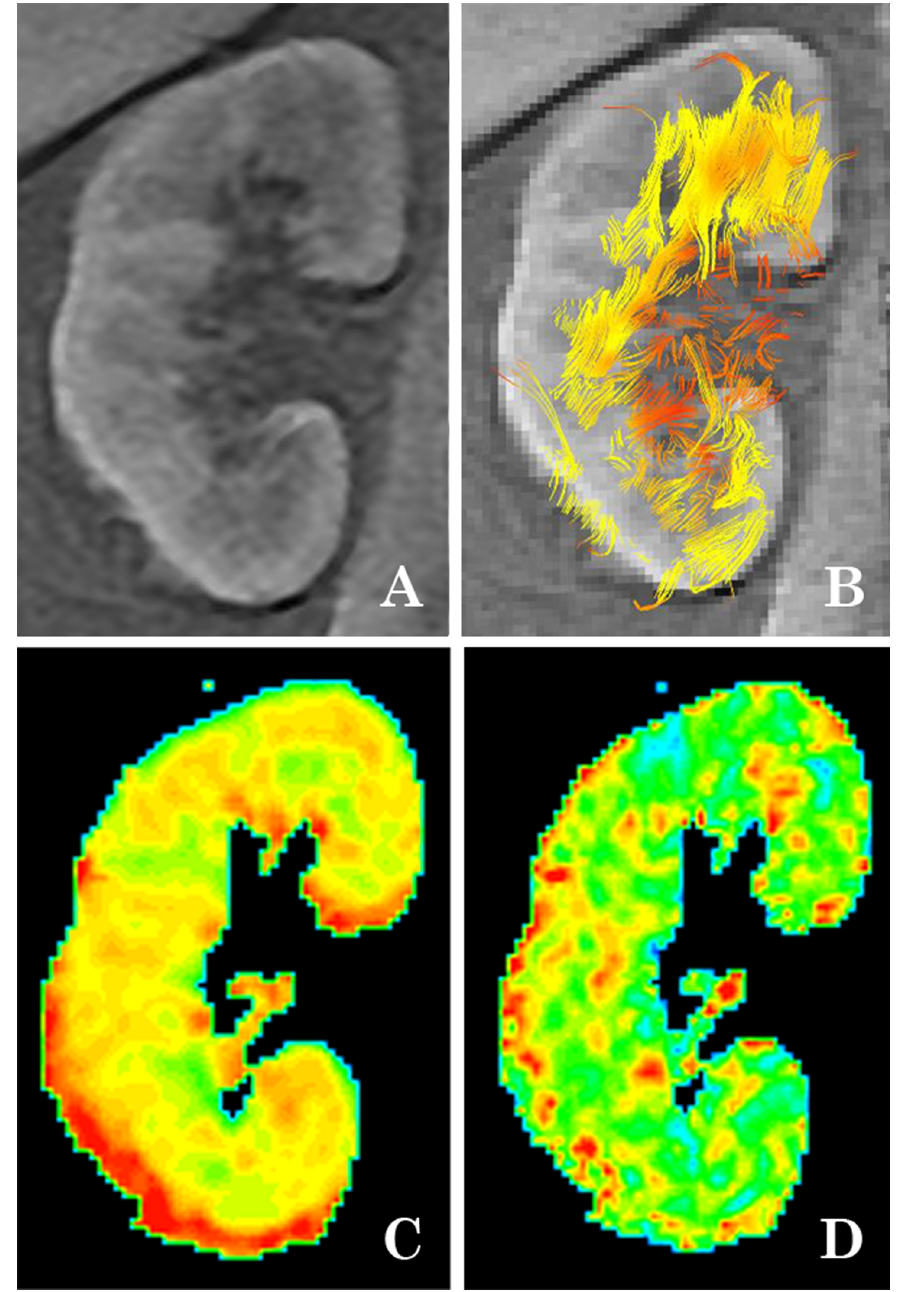
Figure1. Anatomic and DTI-MRI map of native healthy kidneys. (A) T 1 INPHASE fat-suppression background reference map; (B) DTI tractographic map; (C) DTI MD pseudo-color map; (D) DTI FA pseudo- color